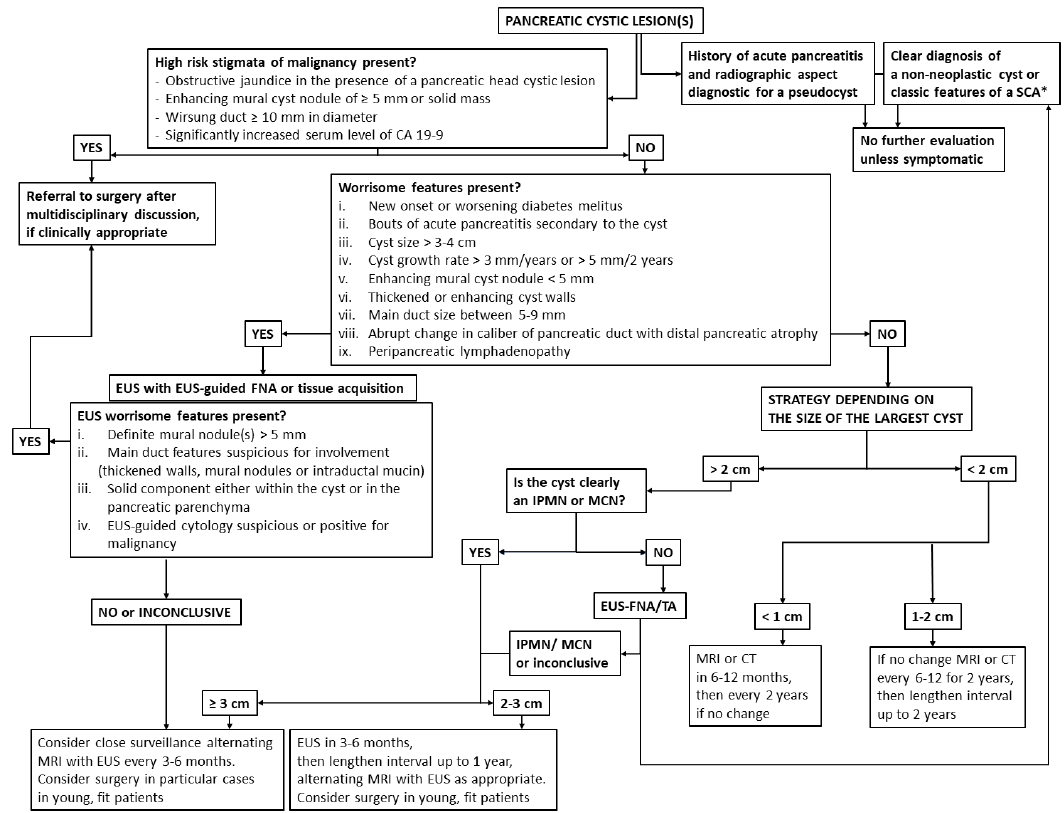
Figure 1. Algorithm of pancreatic cystic lesions (PCLs) diagnosis and management. * Radiographic features diagnostic of a serous cystadenoma are its microcystic appearance and presence of a stellate central scar.